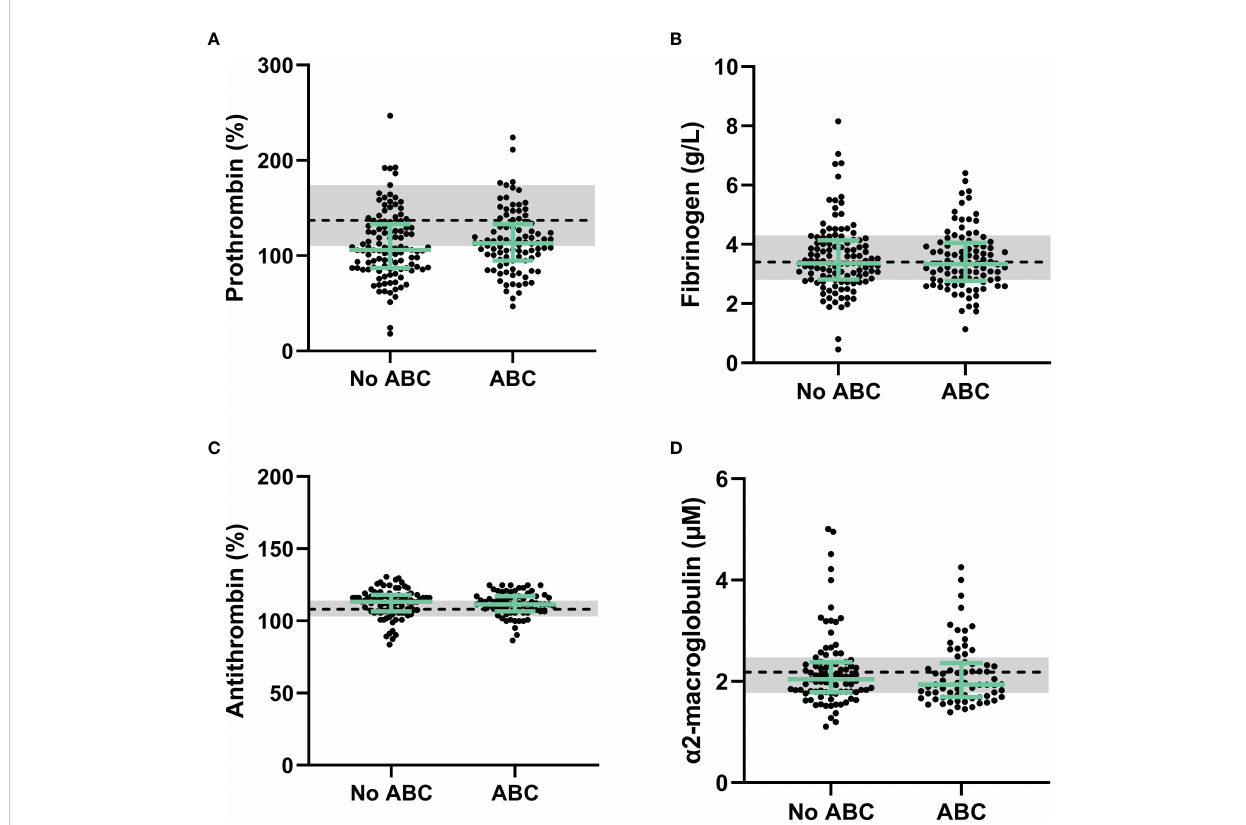
FIGURE 1 Procoagulant and anticoagulant factors in PLHIV strati fi ed for ABC-based treatment. (A) Although prothrombin levels in PLHIV were lower than uninfected controls, prothrombin levels did not differ between PLHIV with an ABC-based treatment or a non-ABC-based treatment. (B-D) Fibrinogen (B) , antithrombin (C) and a 2-macroglobulin (D) levels were comparable between ABC-based and non-ABC-based treated PLHIV, and between PLHIV and uninfected controls. Data of PLHIV participants with and without ABC-based treatment are represented as dots with green bars indicating the group median and interquartile range. For comparison, the median of the controls without HIV is shown as a black dashed line and the interquartile range is depicted as a grey box. ABC, abacavir; ETP, endogenous thrombin potential; PLHIV, people living with HIV;.